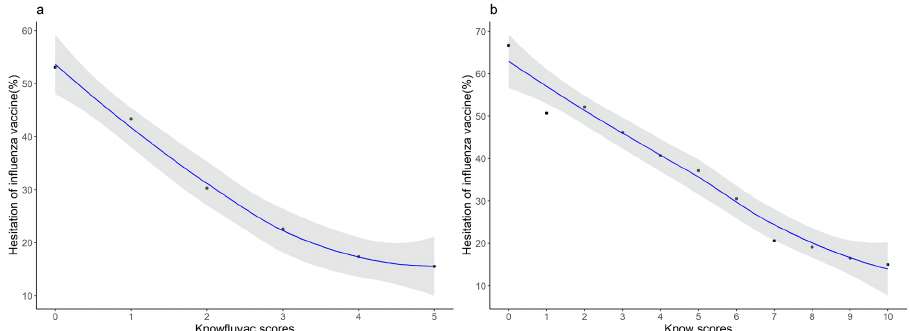
Figure 4. LOESS regression analysis of the trend of knowledge score and IVH proportion: ( a ) knowledge score on seasonal influenza vaccine; ( b ) knowledge score on the total.